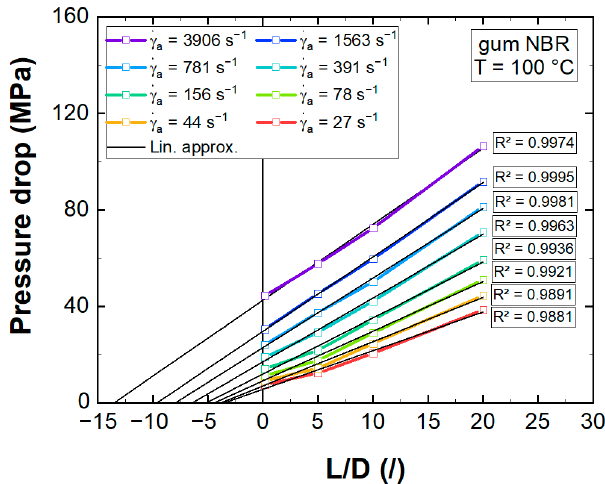
. γ a ) in dependence of the